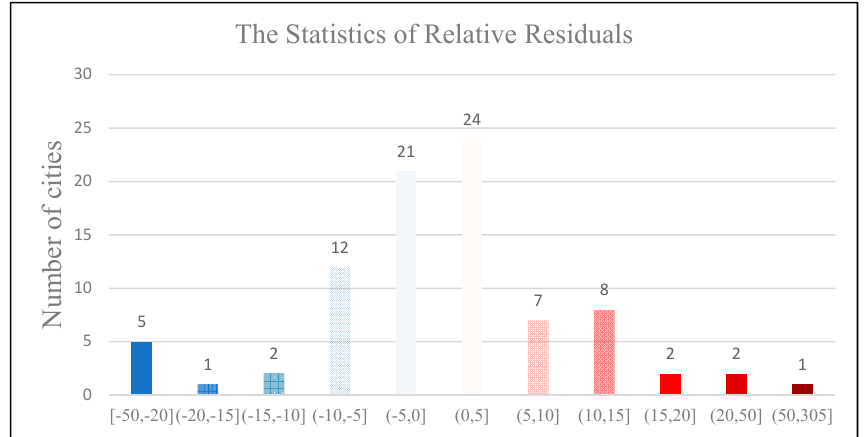
Figure 11. The statistical result of the absolute residuals by using OSM road network density and population.